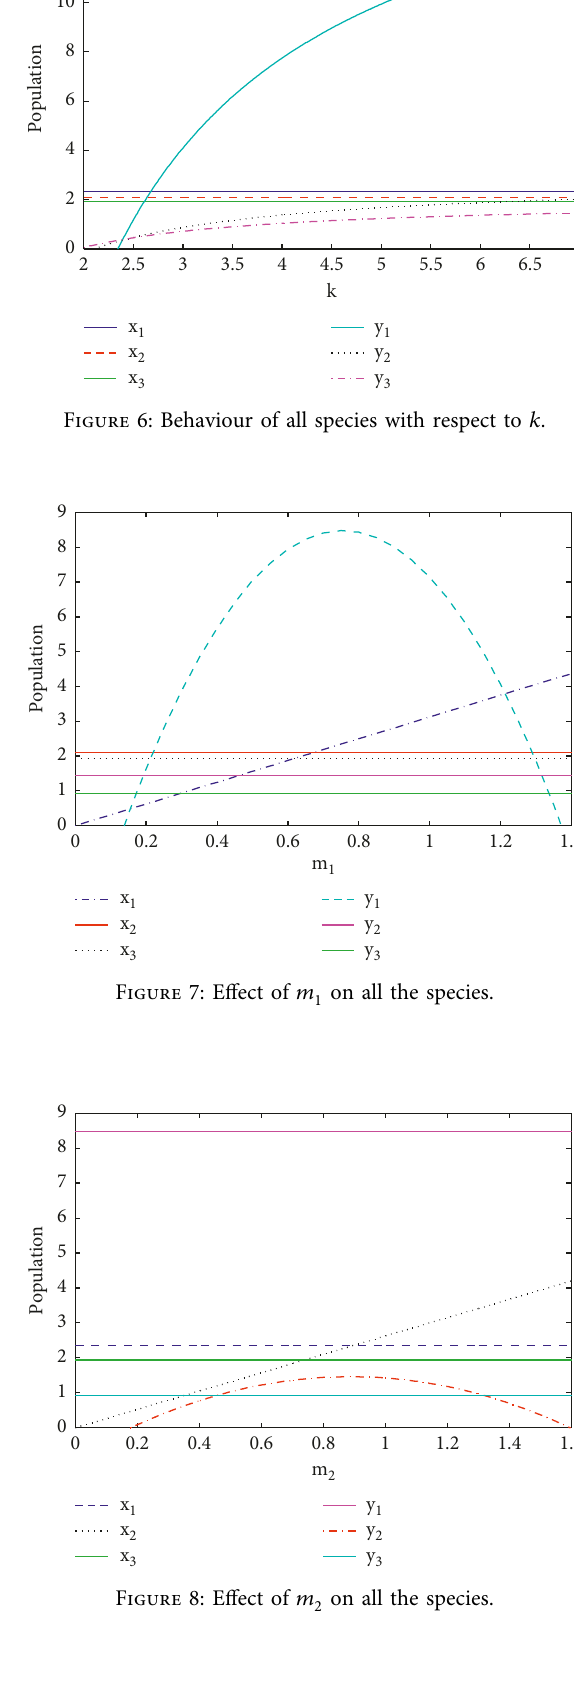
on all the species. 2